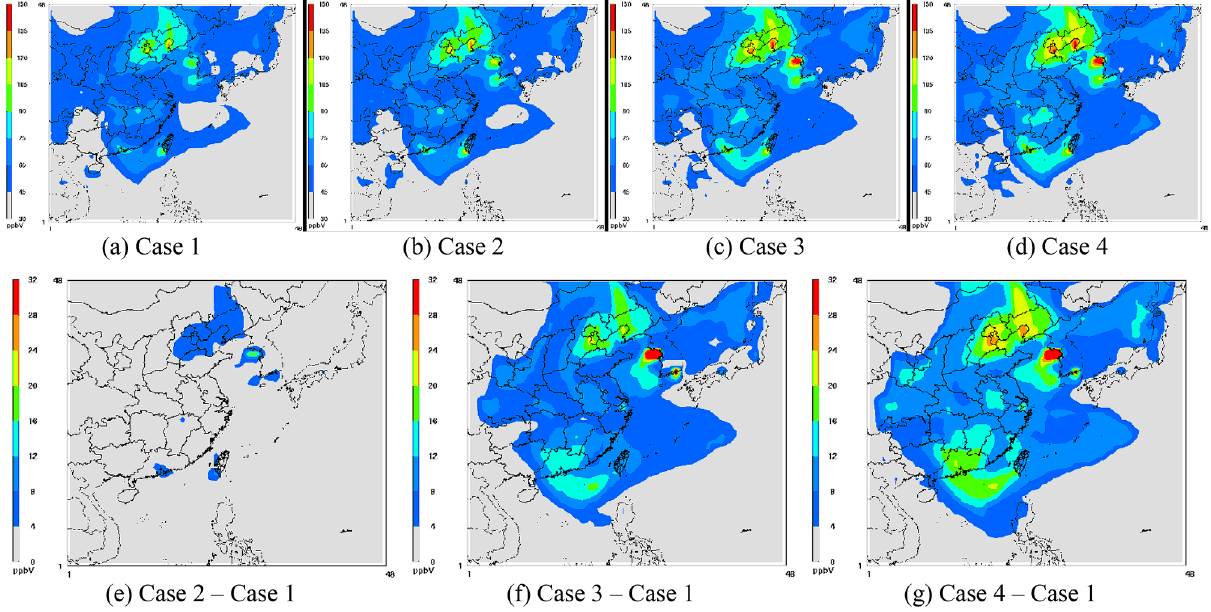
Figure 4. Isopleths of the O 3 level at 2 pm on May 27, 2003, in Domain 1 [the figures are produced with Package for Analysis and Visualization of Environmental data (PAVE) v2.3.2, http://paved .sourc eforg e.net/].